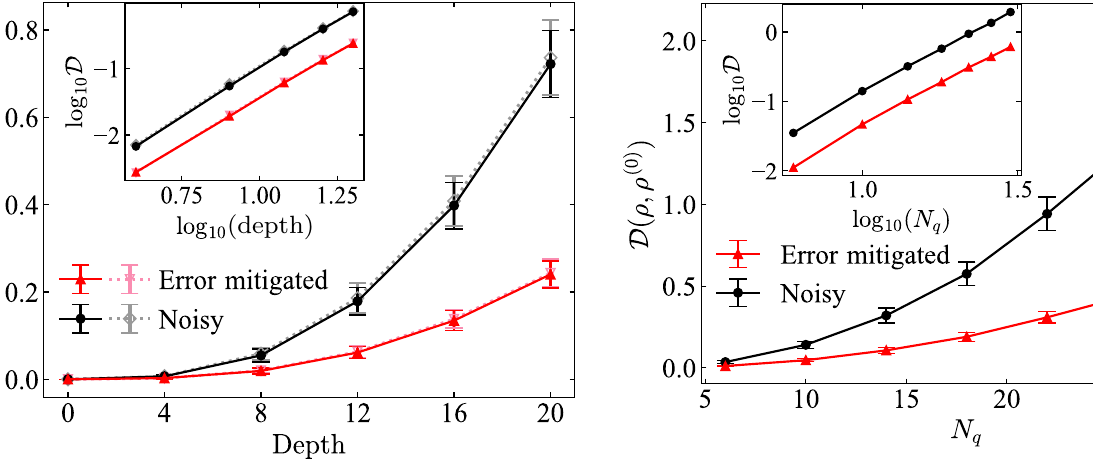
FIG. 8. Distance between ρ from noisy or error-mitigated cir- cuits and ρ ( 0 ) from ideal circuits. The average error rate for two-qubit gates is ε 2 = 0.01, and the system size is N q = 20. Solid and dotted lines describe circuits without and with global N q -qubit depolarizing noise E [ N q ] , respectively, the error rate of which is ε n = 0.05. We take the logarithmic in the inset.